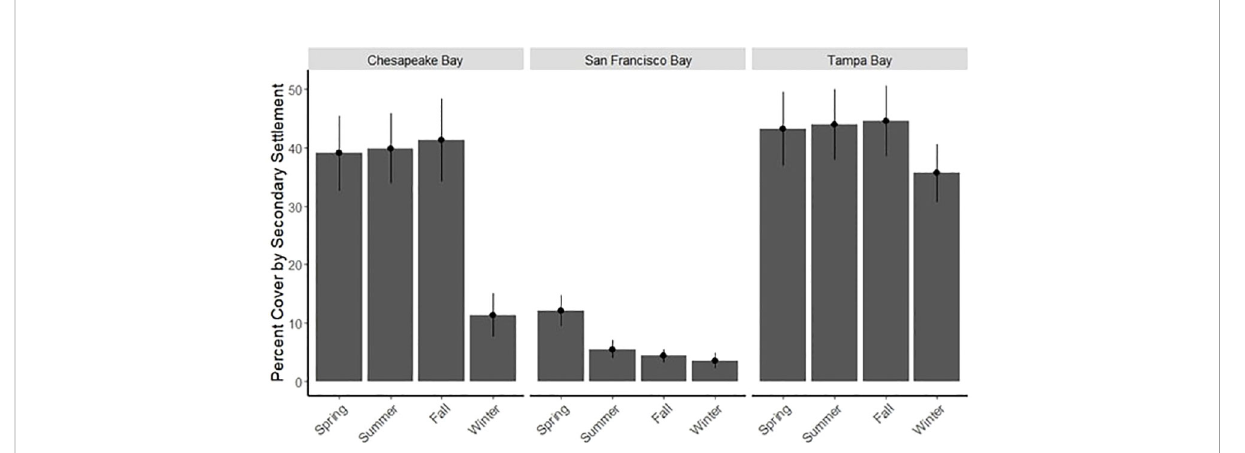
FIGURE 8 Average seasonal secondary percent cover by bay (± SE) for 3-month panels deployed during period 1